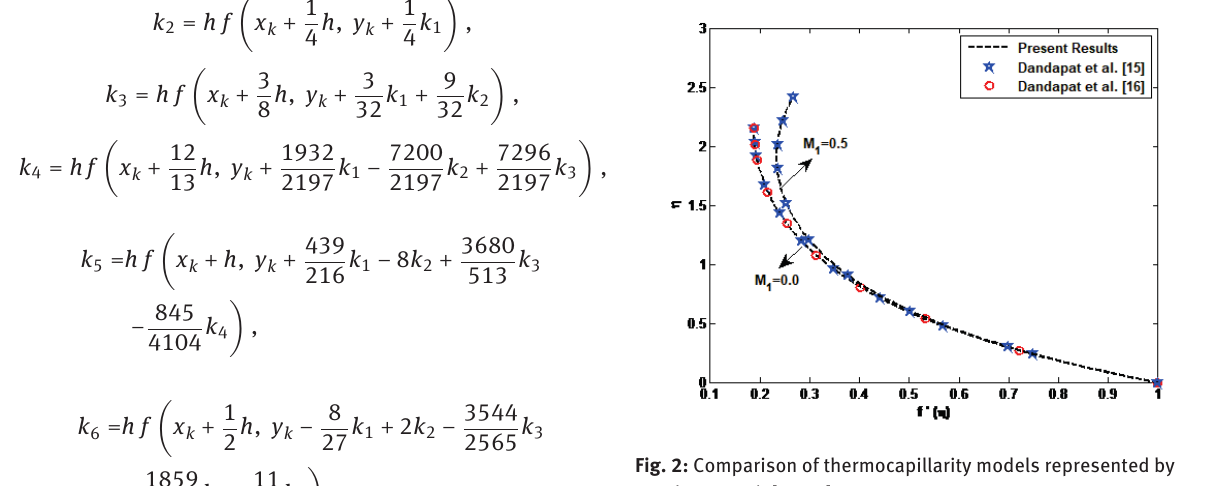
Fig. 2: Comparison of thermocapillarity models represented by Dandapat et al. [15, 16]